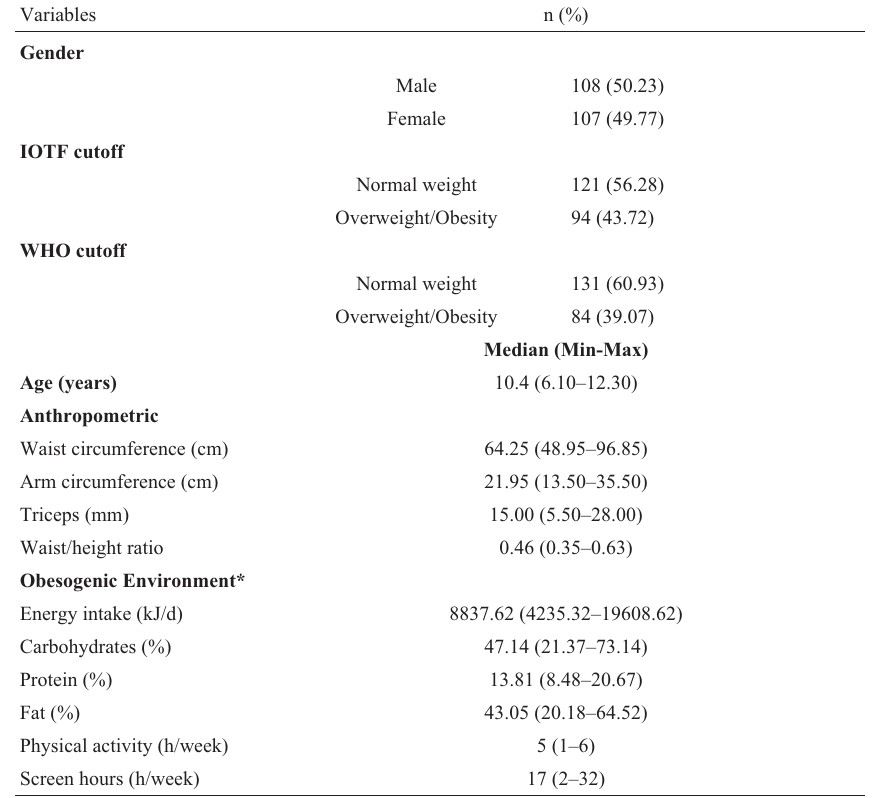
Table 1 - General characteristics of the population